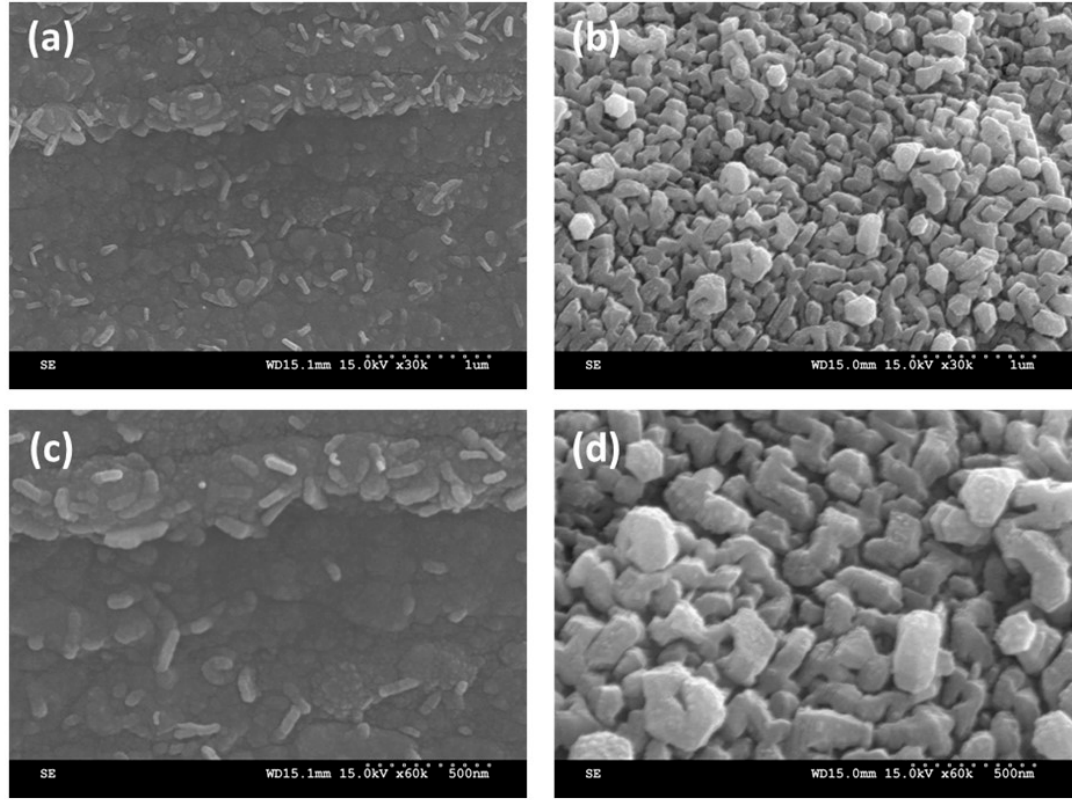
Figure 2. Typical SEM images of S-SUS ( a , c ) and NiS x /SUS ( b , d ) at scale of 1 μ m and 500 nm, respectively.